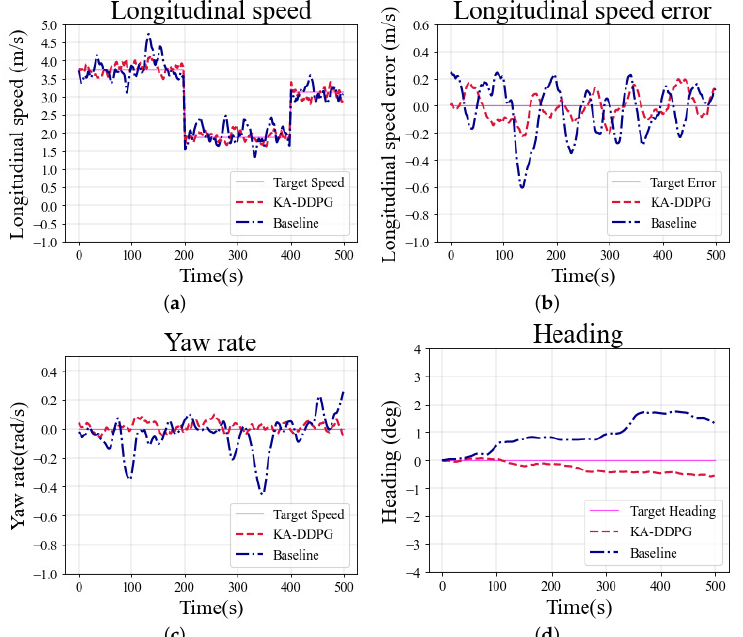
Figure 8. Tracking performance in the straight scenario: ( a ) longitudinal speed tracking; ( b ) longitu- dinal speed error; ( c ) yaw rate tracking; and ( d ) heading.